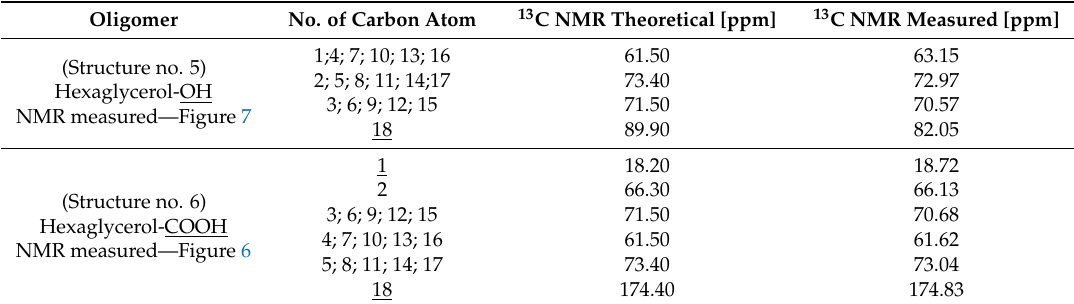
Table 2. Chemical shift values for the signals determined from the 13 C NMR analysis versus those calculated for hexaglycerol with two –OH groups and hexaglycerol with the carboxyl group at the α - carbon atom.